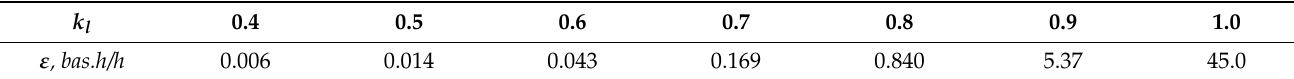
Table 4. Dependence ε = f ( k l ) at x = − 1, k u =